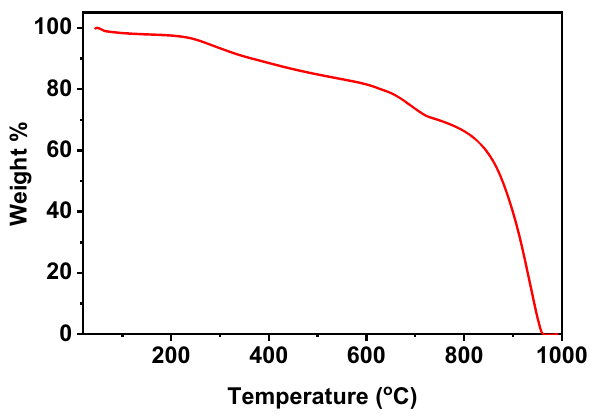
Fig. 9 a and b Cyclic voltammogram for different electrodes and dif- ferent saturated electrolytes, a for steel substrate and b for nickel sub-